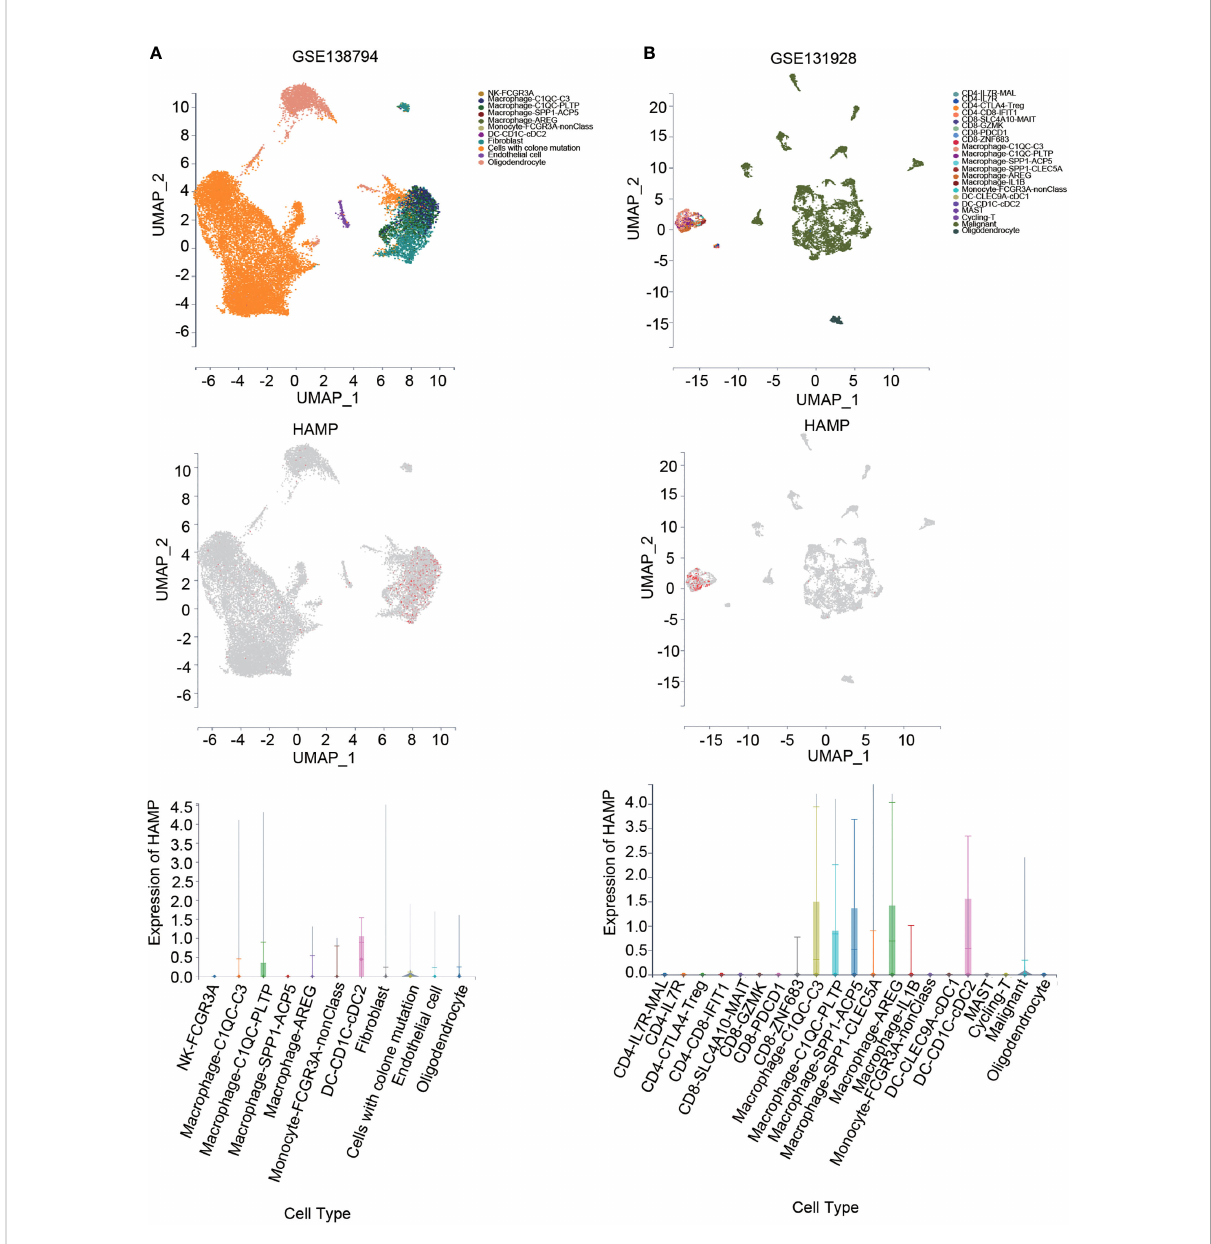
FIGURE 9 Expression of hepcidin at the single-cell level using the scTIME portal database. (A) UMAP plot of all cells from the original article using the GSE138794 dataset (upper panel). UMAP plot of the hepcidin gene based on scRNA-seq data (middle panel). The expression of hepcidin in different cells (lower panel). (B) UMAP plot of all cells from the original article using the GSE131928 dataset (upper panel). UMAP plot of the hepcidin gene based on scRNA-seq data (middle panel). The expression of hepcidin in different cells (lower